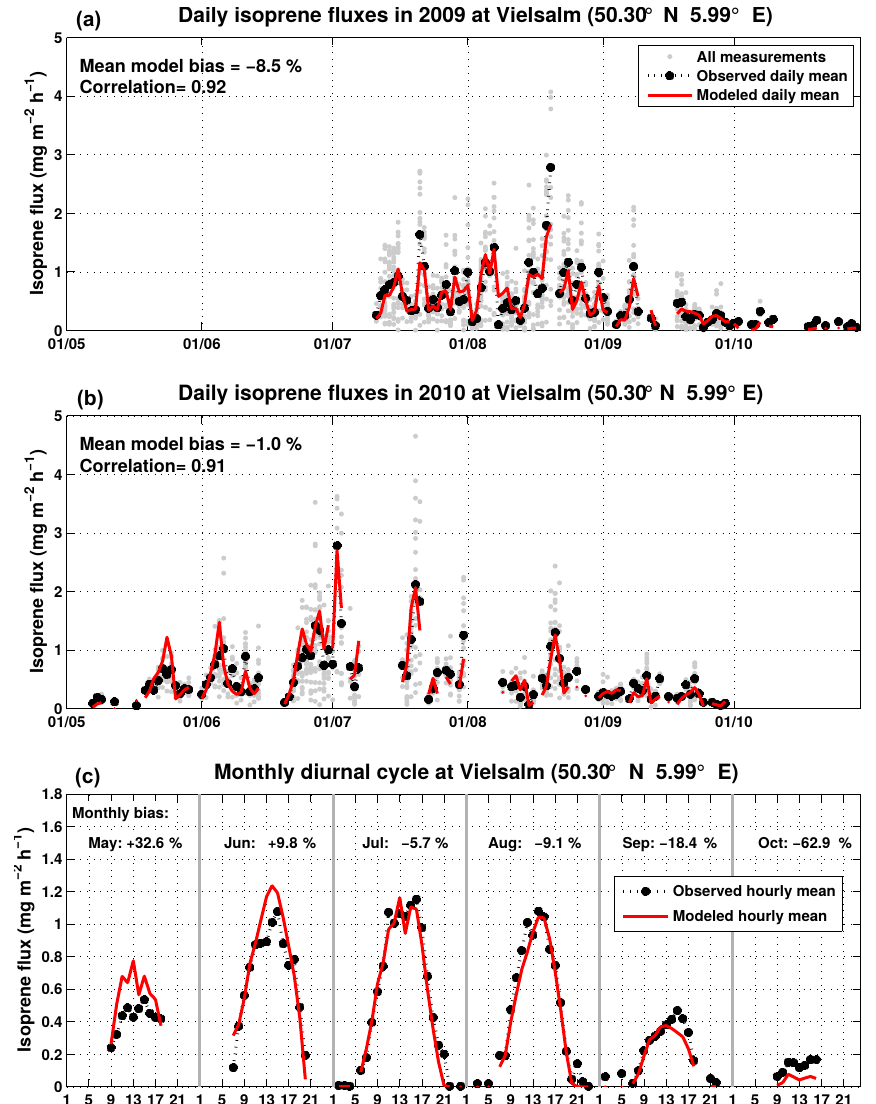
Figure 6. Modeled (red) and measured (black and gray) daily isoprene fluxes in Vielsalm in 2009 (Laffineur et al., 2011) and in 2010 (Laffineur et al., 2013). The model (H3 simulation) uses the local emission factor (SEF = 2.88mgm − 2 h − 1 ). The lower panel shows the monthly diurnal cycle for the modeled (red) and measured (black) isoprene fluxes, as well as the monthly bias.